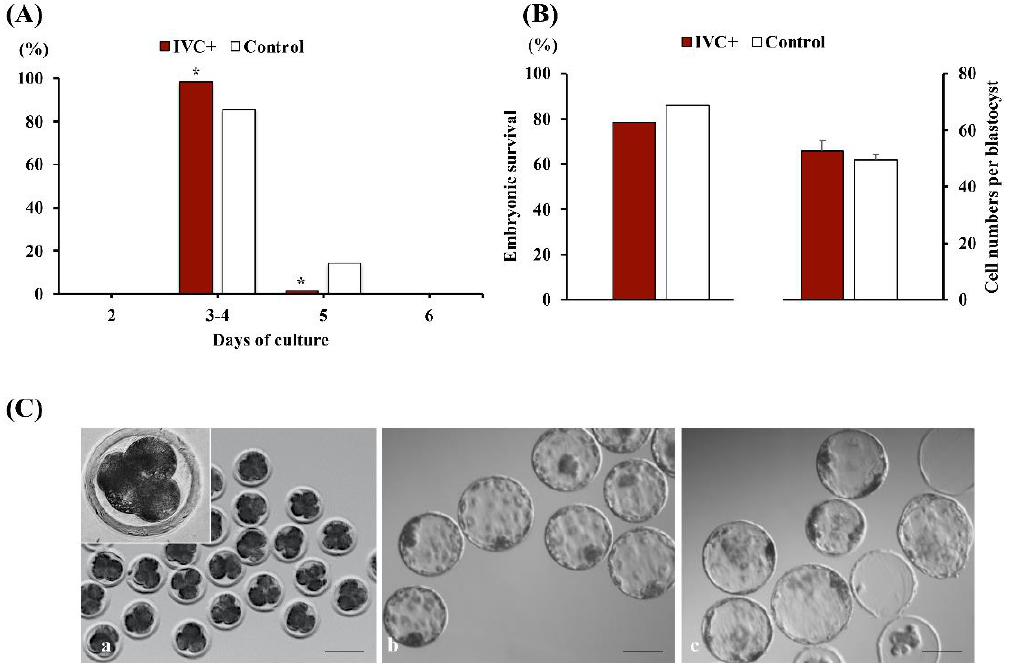
Figure 8. Effect of melatonin on the in vitro development of in vivo-derived 4-cell embryos. ( A ) Effects of the addition of 1 nM melatonin to the culture medium on the percentages of in vivo-derived 4-cell embryos developing to the expanded blastocyst stage or later stages at different days of culture. The embryos were cultured in culture medium with (IVC+; n = 70) or without (control; n = 76) melatonin. * p < 0.004 compared to the control group. ( B ) Post-warming survival and total cell number per blastocyst of vitrified-warmed expanded blastocysts formed from in vivo-derived 4-cell embryos cultured in a medium supplemented with (IVC+; n = 68) or without (control; n = 76) melatonin. Data are presented as percentages and means ± SEM (four replicates). ( C ) Representative images of in vivo-derived 4-cell embryos ( a ), fresh ( b ), and vitrified-warmed ( c ) blastocysts produced from the in vitro culture of in vivo-derived 4-cell embryos. Scale bar: 100 µm.